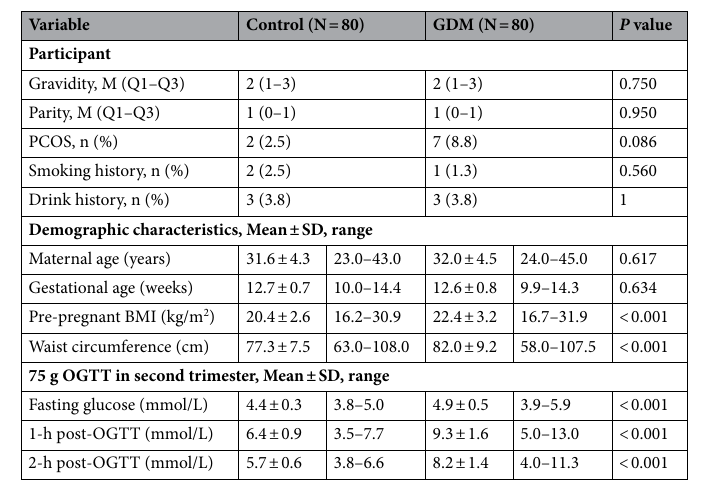
Table 1. Study participant’s characteristics. Abbreviation: M median; (Q1–Q3), interquartile ranges, PCOS polycystic ovary syndrome.